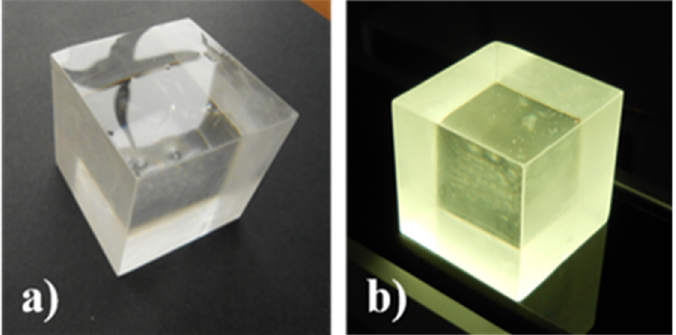
Figure 4. CsI(Tl) scintillator crystal coated by Technovit Epox resin under visible ( a ) and UV light ( b ).